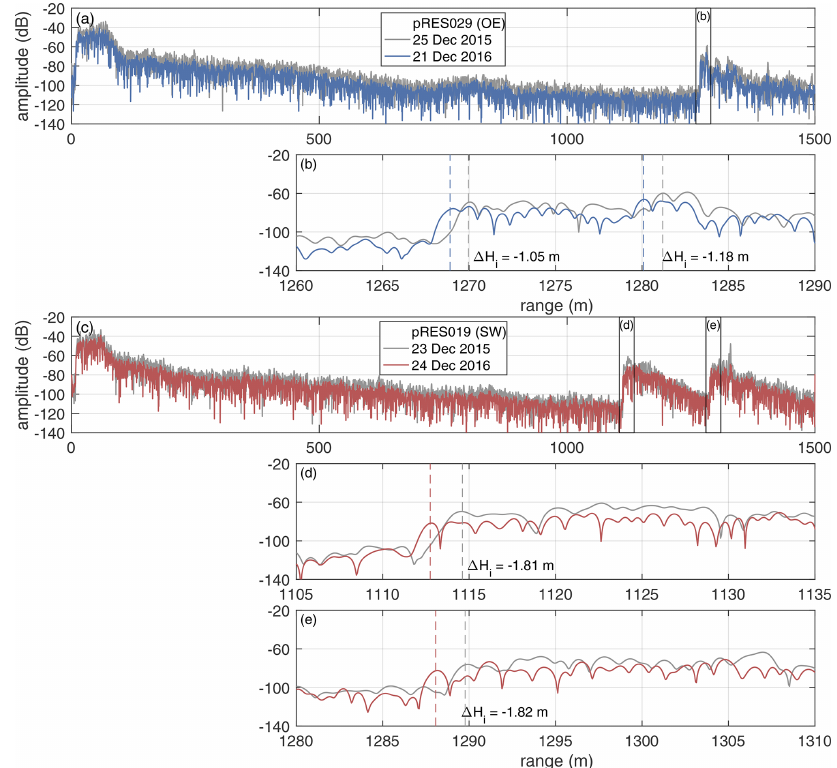
Figure A3. Amplitude profiles of two measurements indicating off-nadir basal reflections. (a, b) First (gray line) and repeated pRES mea- surement (blue) at location OE at the cross-section with a distance of 43km from the grounding line. (b) Enlarged basal section, visualized by black boxes in panel (a) . Vertical dashed lines mark the ice thickness and (cid:49)H i the change in ice thickness between both visits for the first and second strong increase in amplitude. (c–e) First (gray line) and repeated pRES measurement (red) at location SW at the cross-section with a distance of 28km from the grounding line. (d, e) Enlarged basal sections, visualized by black boxes in panel (c) . Vertical dashed lines mark the ice thickness and (cid:49)H i the change in ice thickness between both visits for the first and second strong increase in amplitude.